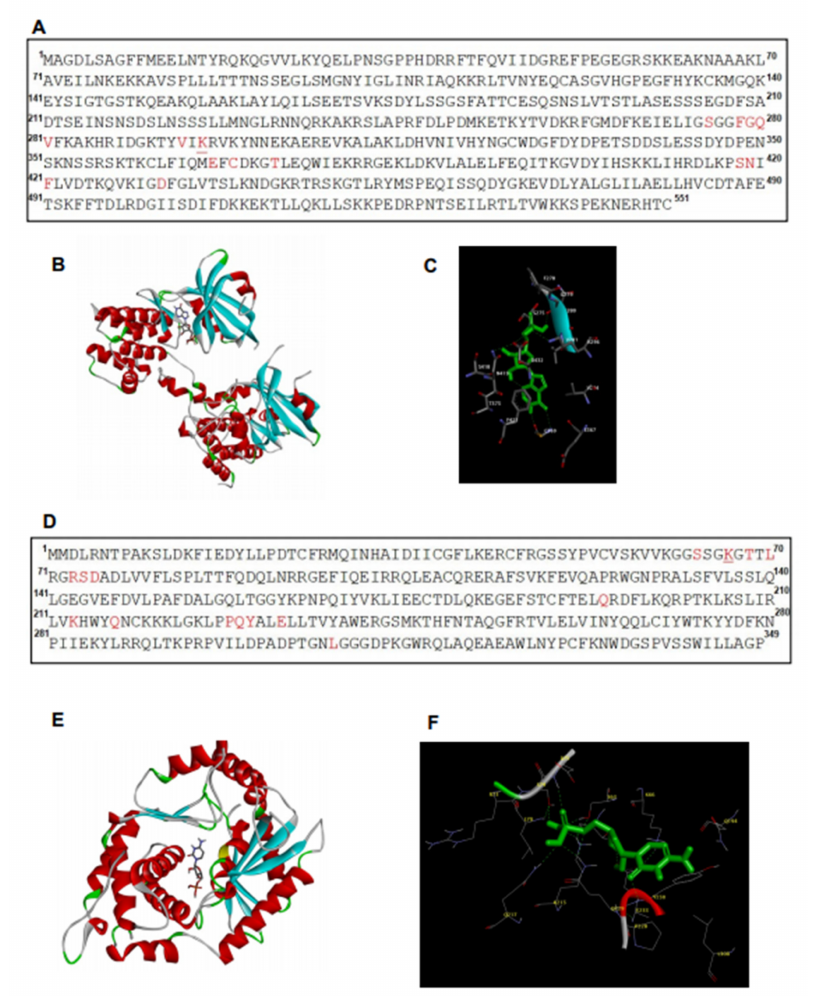
Figure 6. The predicted key residues of PKR and OAS involved in Hiltonol-binding. Potential Hiltonol- interacting residues and binding structures of: ( A – C ) PKR and ( D – F ) OAS are analyzed by AutoDock. The full structures of PKR (PDB: 6D3K) and OAS (PDB: 4IG8) were used for analysis. ( A , D ) The key residues of PKR and OAS involved in Hiltonol-binding are highlighted in red. The model shows that Lys296 of PKR and Lys66 of OAS (underlined) interact with Hiltonol, which is consistent with earlier reports [6–8]. The binding structures of PKR-Hiltonol and OAS-Hiltonol are shown in ( B , E ), respectively. The α -helices and β -sheets are colored red and blue, respectively. The coils are in “light grey” and the turns are in “green”. ( C , F ) show superimpositions of the binding poses of PKR and OAS with Hiltonol (green). Nitrogen and oxygen atoms are depicted in blue and red,